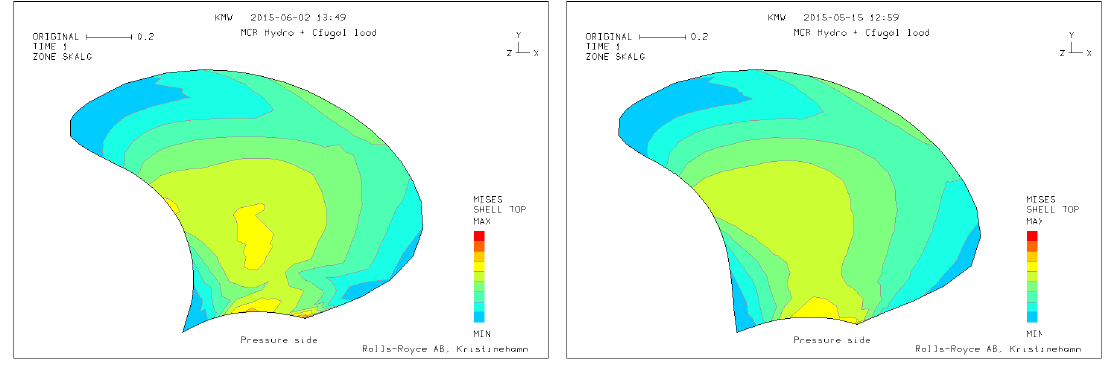
Figure 18. Cavitation performance ( a ) and FEM simulation of hydrodynamic and centrifugal loads of benchmark propeller case Opt-3 ( b ) and optimised design (Opt-3-15) ( c